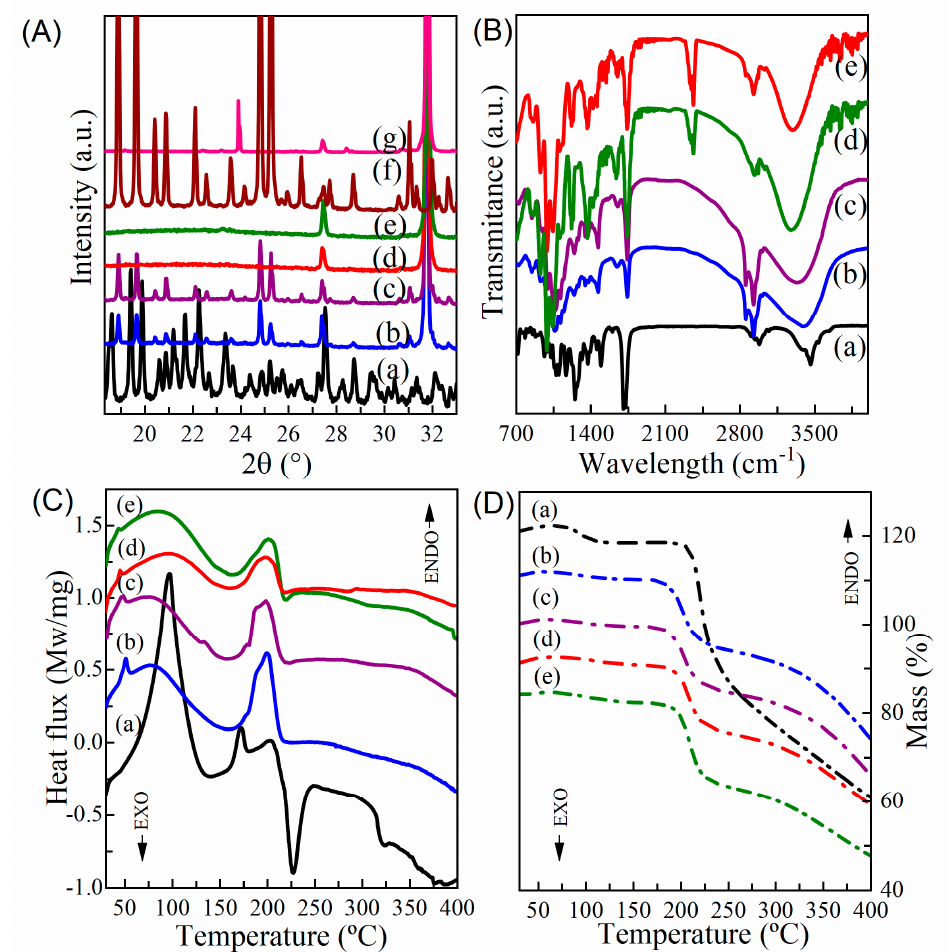
Figure 5. Solid state characterization of lyophilized liposomes: ( A ) powder X-ray: diffraction patterns of DTX ( a ), unloaded liposome ( b ), liposome DTX ( c ), unloaded immunoliposome ( d ), DTX immunoliposome ( e ), PBS ( f ) and sucrose ( g ). ( B ) FTIR: DTX ( a ), unloaded liposome ( b ), liposome DTX ( c ), Cetuximab ( d ), unloaded immunoliposome ( e ). ( C ) Differential scanning calorimetry: curves of DTX ( a ), unloaded liposome ( b ), DTX liposome ( c ), unloaded immunoliposome ( d ) and DTX immunoliposome ( e ). ( D ) Thermogravimetry: curve of DTX ( a ), unloaded liposome ( b ), DTX liposome ( c ), unloaded immunoliposome ( d ) and DTX immunoliposome ( e ). The curves were vertically translated for clarity.